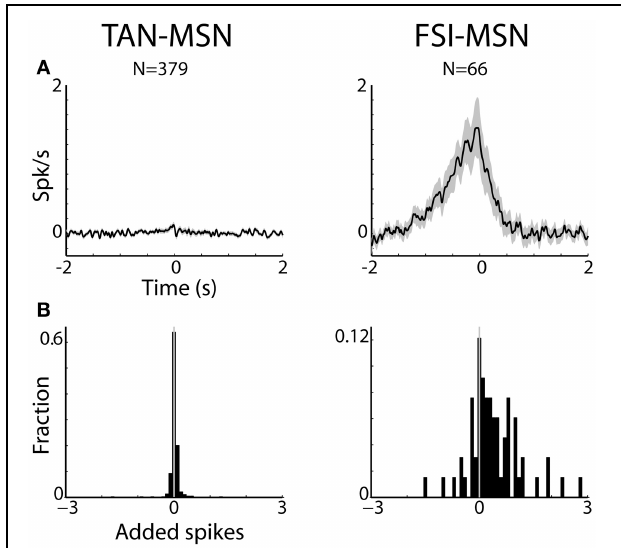
FIGURE 5 | MSNs are differentially correlated with striatal interneurons. (A) Raw (with no normalization) cross correlation histograms (CCH) between pairs of striatal interneurons and MSNs averaged over all pairs. Average and SEM; black line and gray shaded envelope, respectively. Abscissa: time in seconds. The MSN (trigger cell) discharge is at time zero. Ordinate: conditional firing rate of the FSI and TAN (reference cell), given a spike of the MSN at time zero. Cross correlation histograms were computed with 1ms bins for ± 2s around the trigger spike and were smoothed using a Gaussian ( SD of 10ms). Left subplot: TAN-MSN. Right subplot: FSI-MSN. N stands for the number of simultaneously recorded pairs. (B) Distribution of the average number of added spikes of the reference (MSN) cell in the corrected CCHs around the time window of ± 1.5s. Abscissa: number of added spikes. Ordinate: ratio of pairs (note the different y-scales).